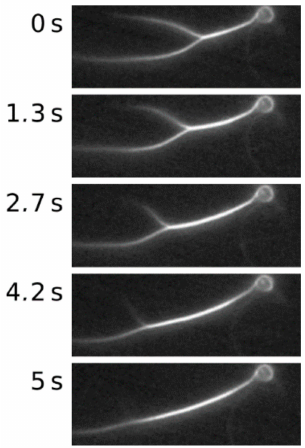
Figure 5. Time lapse of the zipping process. Bundles were thickened by merging with other bundles. This was achieved by dragging the bundle with the optically trapped bead into the vicinity of another, freely floating